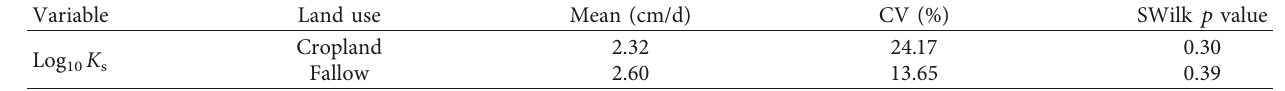
Table 1: Descriptive statistics of log